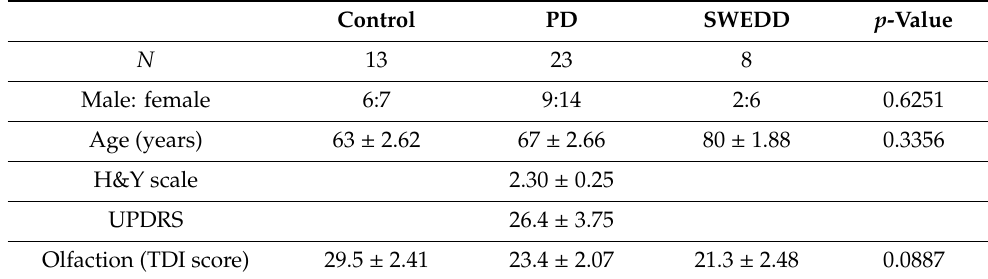
Table 1. Basic demographic information, clinical motor assessment, and olfactory scores of Parkinson’s disease (PD), scans without evidence of dopaminergic deficits (SWEDD) patients, and healthy controls. Control PD SWEDD p -Value N 13 23 8